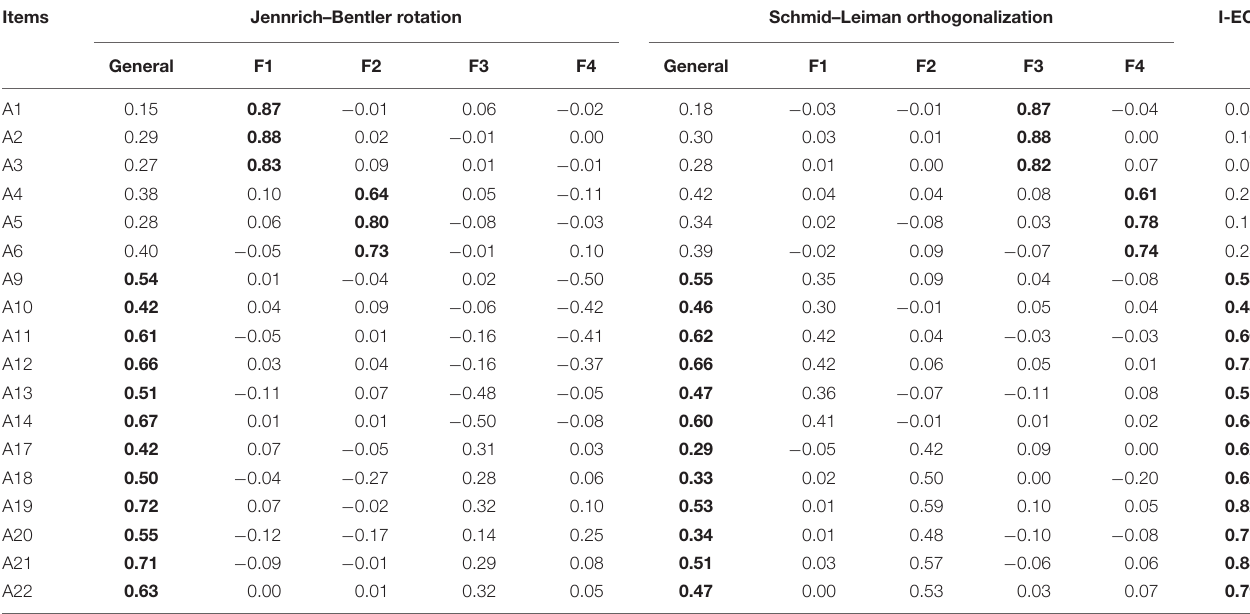
TABLE 5 | Results of bifactor analyses of the Implicit Theories Scale from Study 2.